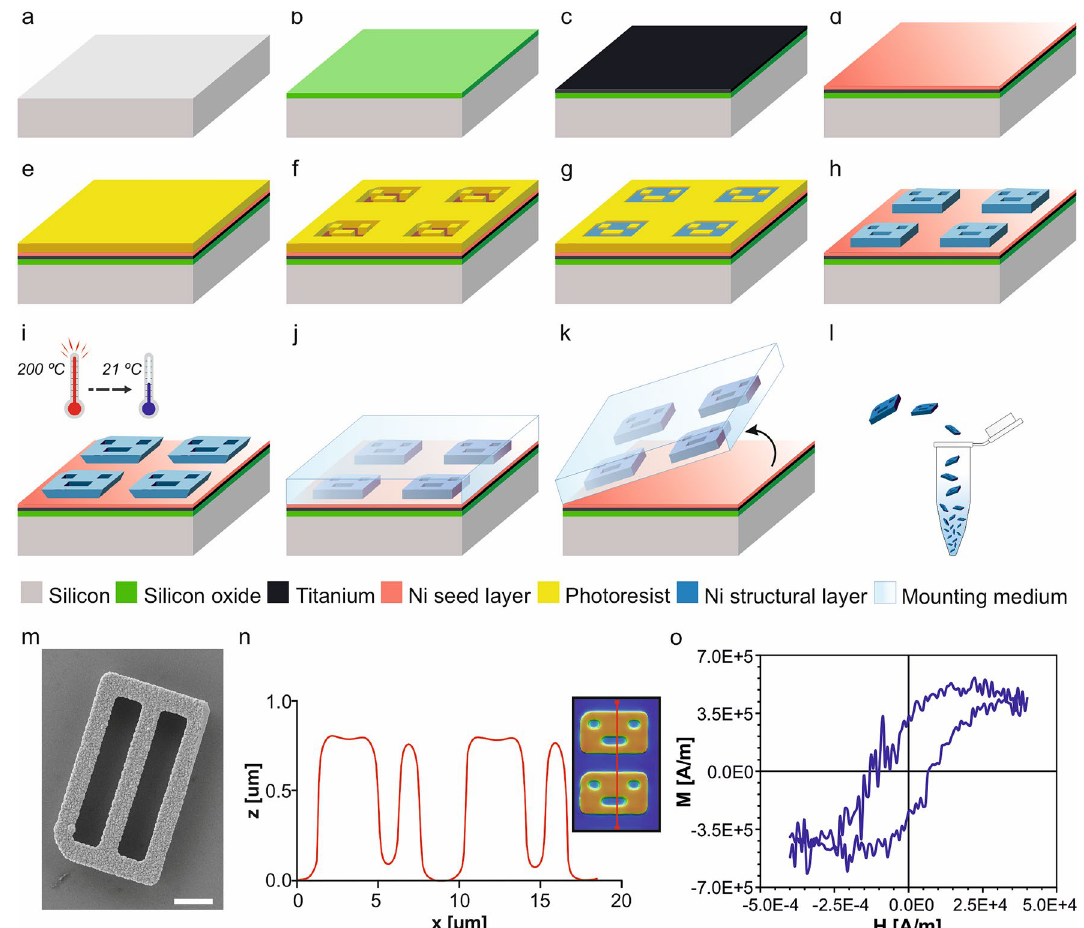
Figure 2. Technology development of the Ni barcodes. ( a ) A silicon wafer substrate as the starting material for the fabrication of the magnetic barcodes. ( b ) 1 µm of silicon oxide was deposited. ( c ) A 50-nm-thick of Ti and ( d ) a 50-nm-thick of Ni were evaporated as metallic seed layers. ( e ) 0.9 µm of photoresist was spun over the surface. ( f ) Patterned photoresist after exposure to ultraviolet light through a photolithographic process to get the inverted barcode pattern. Barcode devices were fabricated from the inverted photoresist pattern. ( g ) 1 µm of Ni was deposited with the electroplating process. ( h ) Removal of the photoresist. ( i ) Thermal-shock was performed after heating the devices at 200 °C for 20 min and followed by a quick cooling down to room temperature. ( j ) A drop of an aqueous mounting medium was cast over the devices. ( k ) Manual peeling of the solidified membrane was performed to release the barcodes. ( l ) Chips were collected in an Eppendorf by dissolving the membrane in water. ( m ) SEM images of a Ni fabricated barcode with code number 0000–0000 = 0, after its release. Scale bar: 2 µm. ( n ) Confocal profiles of Ni barcodes (right inset shows the scanned line), z represents the vertical dimension and x the length along the scanned line. ( o ) Hysteresis loop of Ni barcodes measured with a VSM for magnetic characterization. M represents the magnetization and H is the applied magnetic